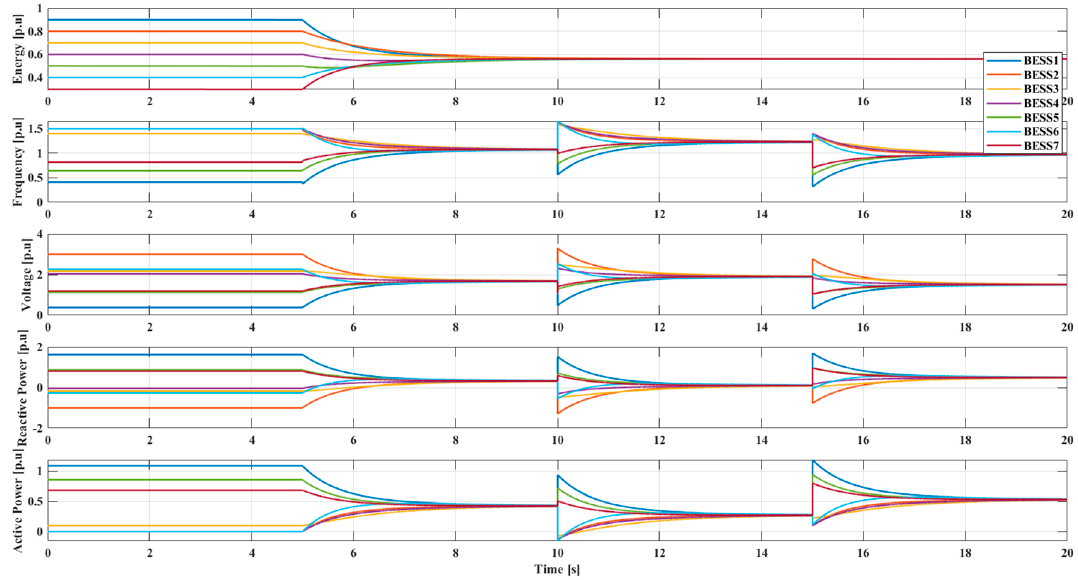
Figure 5. Simulation result without a leader regardless of geographic factors (case 1).